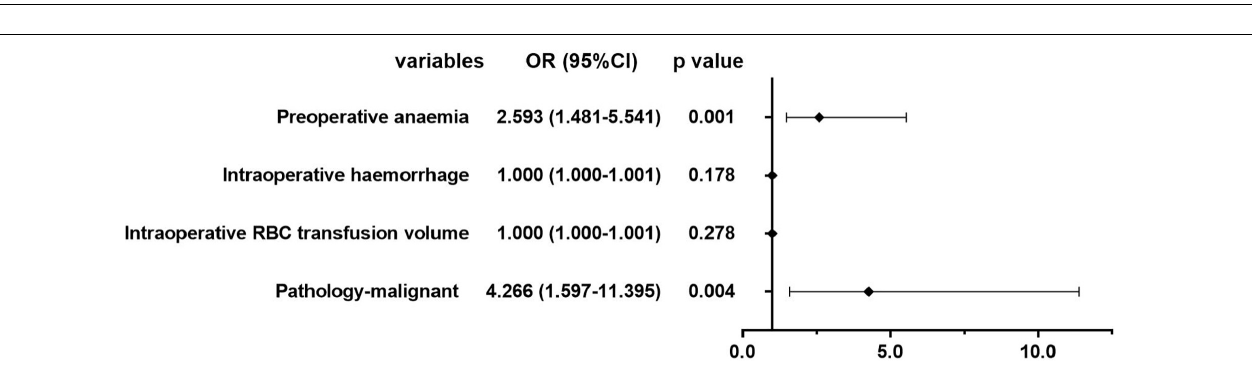
FIGURE 5 | Univariate analysis of the risk factors of severe postoperative complications in patients after propensity score matching (PSM).